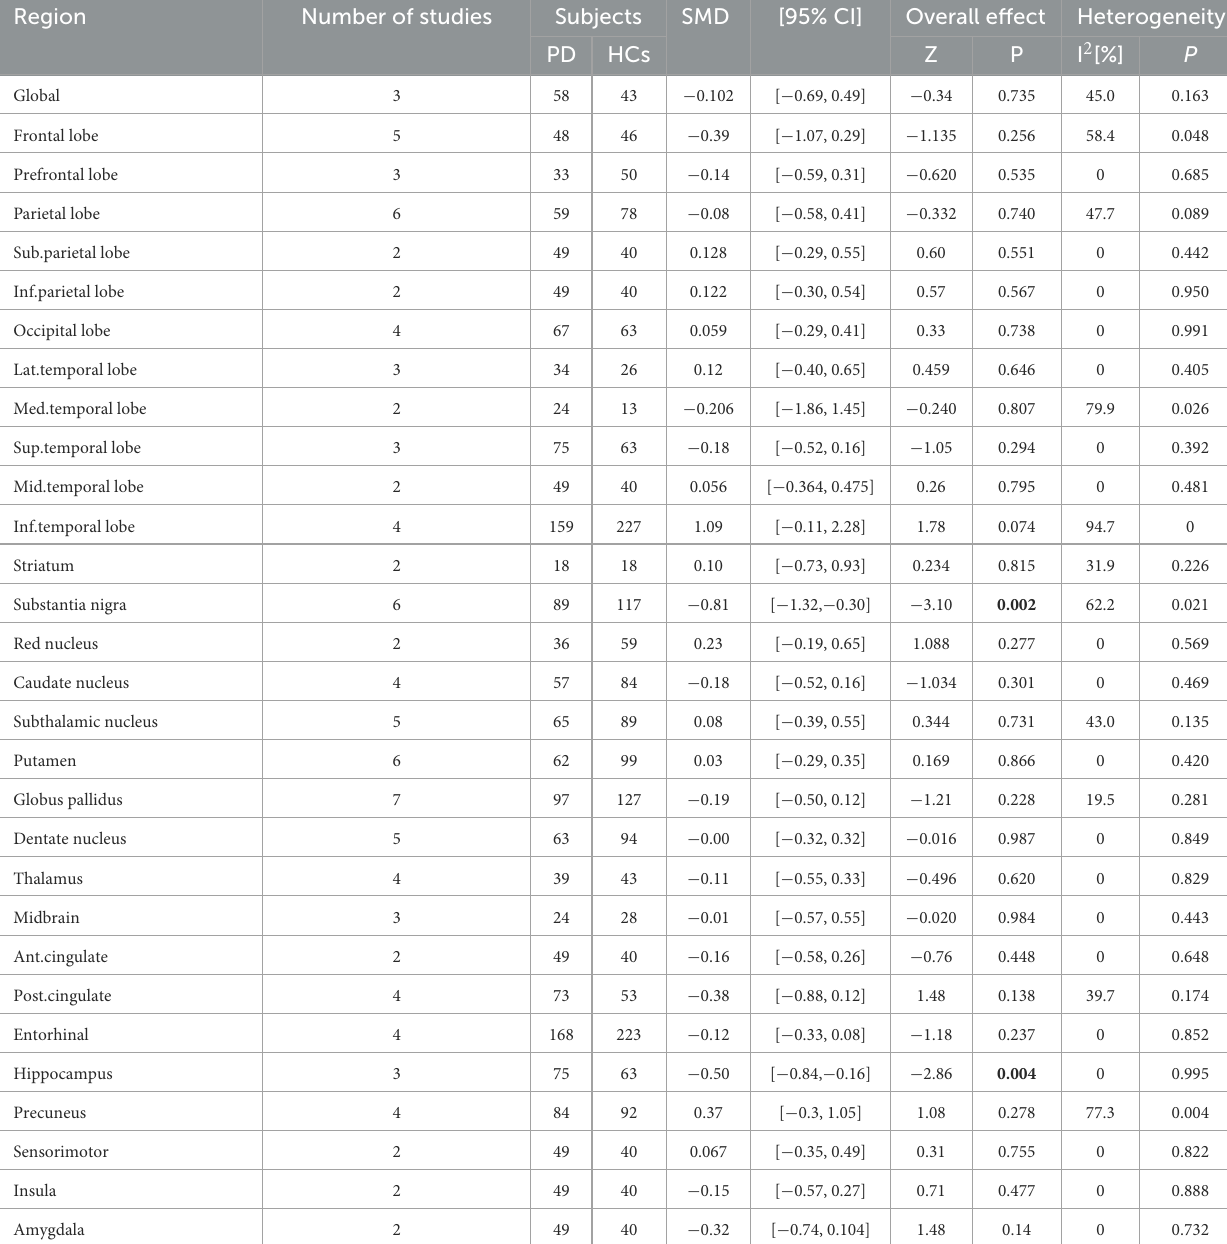
TABLE 2 Random effects meta-analyses results between PD and HCs subjects. Region Number of studies